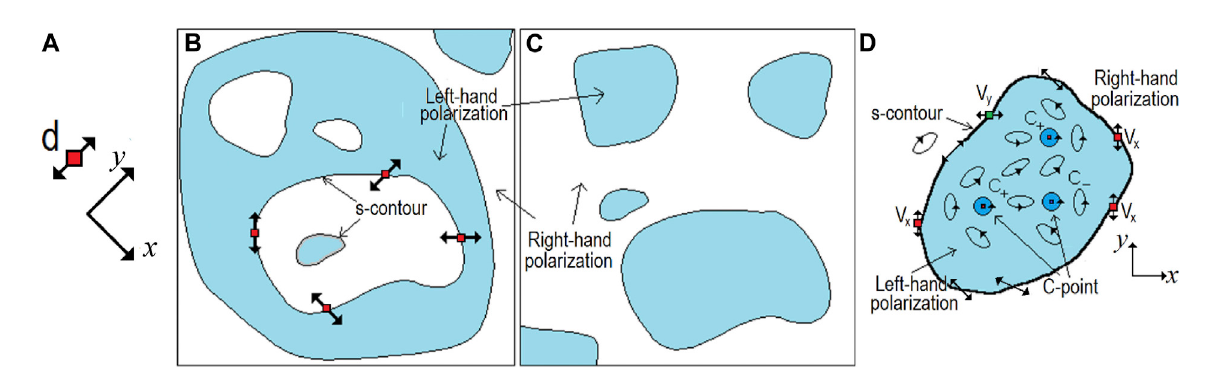
FIGURE 2 (A) Illustration of the transverse- fi eld disclination; (B) s -contour structure of the “ matryoshka ” type; (C) the structure of s -contours ( “ islands in the ocean ” ), forbidden for an absolutely random fi eld, but which can be realized in fi elds with predominantly circular polarization; (D) area of the fi eld containing C -points enclosed by the s -contour where the fi eld is linearly polarized with variable azimuth; points of x -oriented ( y -oriented) polarization are highlighted as vortices of the vanishing component V y (V x